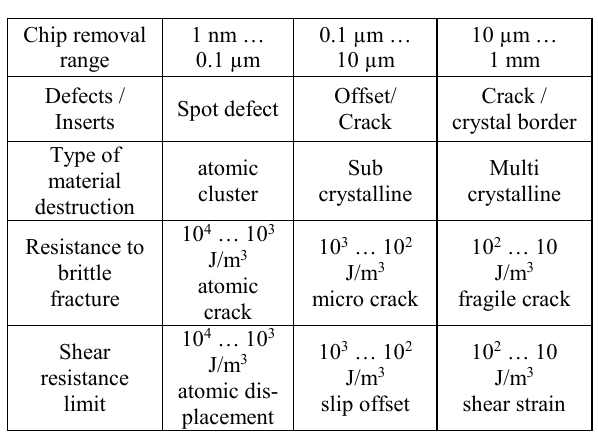
Table 2. Values of energy ranges, required for cutting of different materials under different cutting conditions [12]